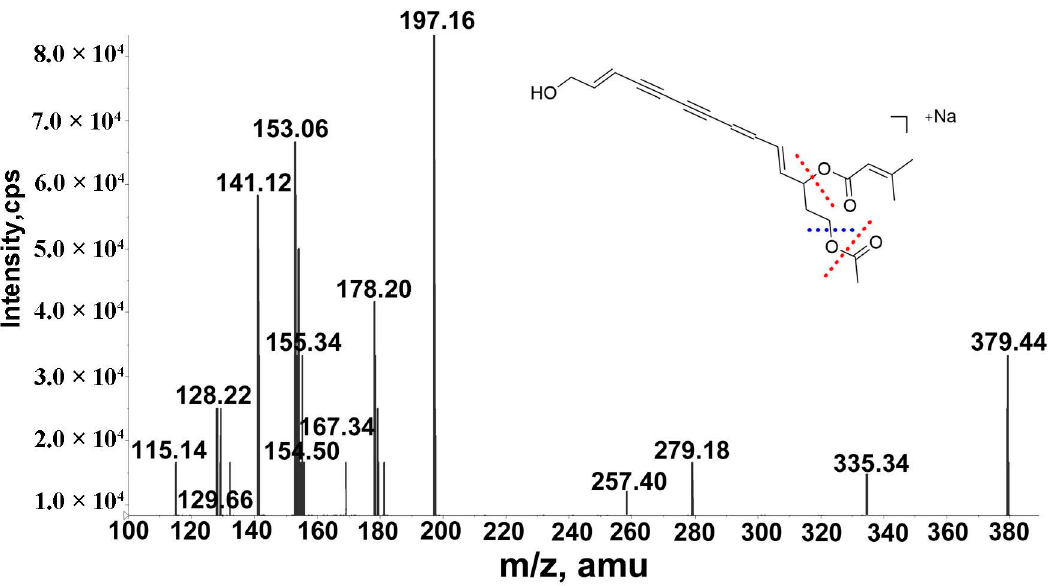
Figure 4. MS n spectrum of 14-acetoxy-12-senecioyloxytetradeca-2E,8EZ,10E-trien-4,6-diyn-1-ol.